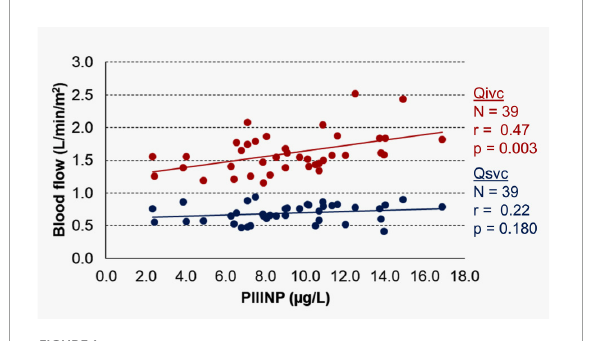
FIGURE1 Correlation between procollagen III N-terminal peptide (PIIINP) and inferior vena cava (Qivc) or superior vena cava (Qsvc) flow.